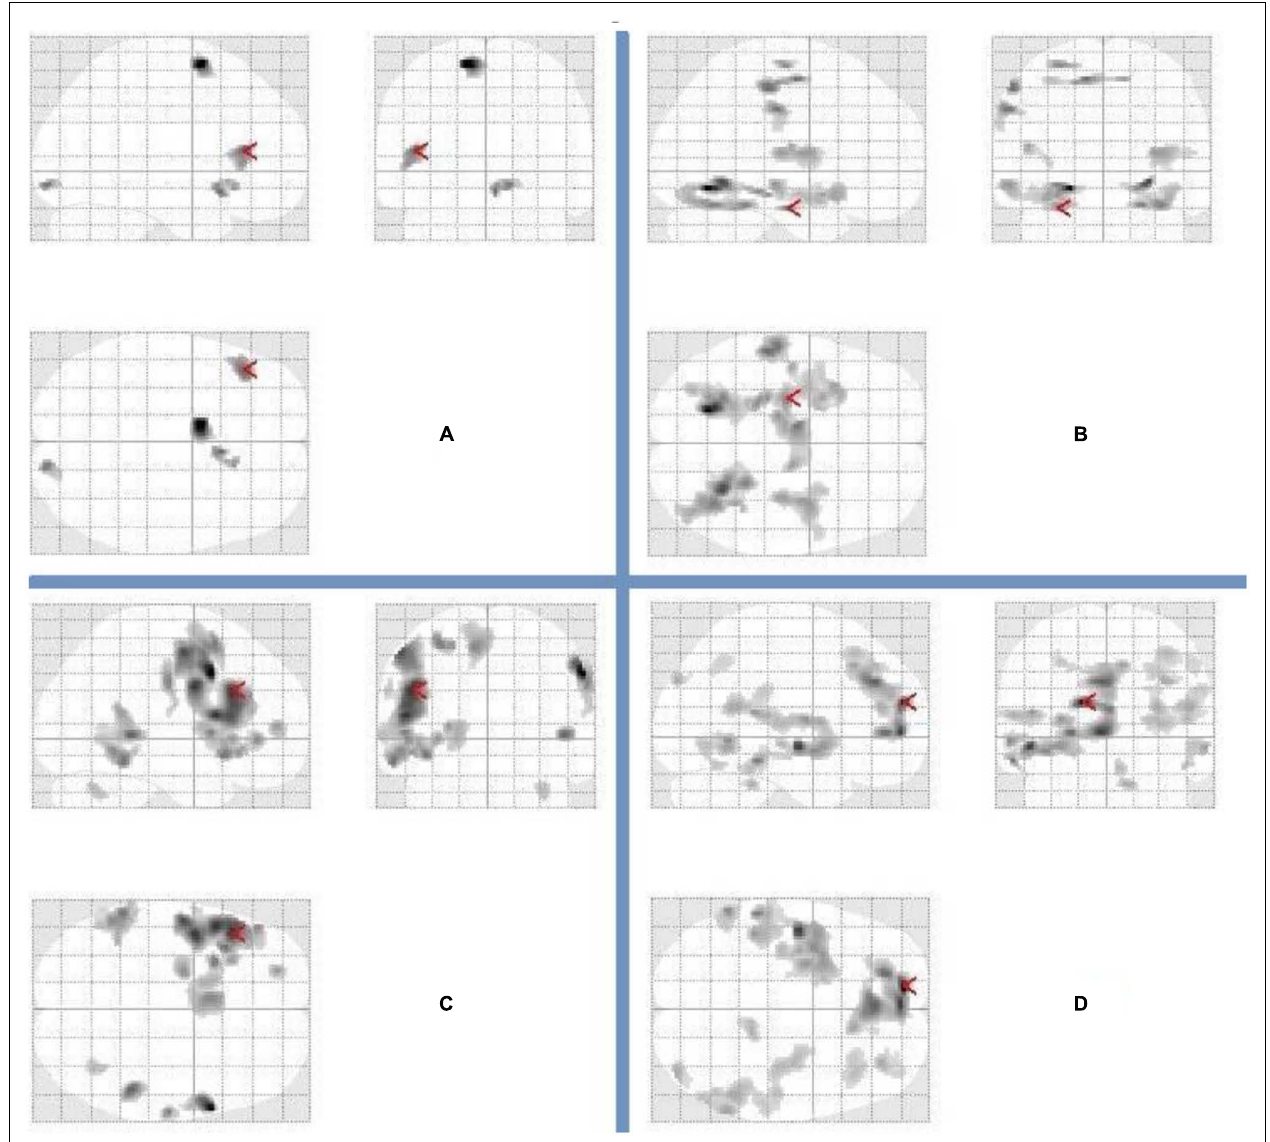
FIGURE 2 | Patterns of brain activation for divergent thinking (fluency) and recalling characteristics following a night of normal sleep and sleep deprivation. Glass brains representing activations in relation to (A) uses–rest following a night of normal sleep (arrow points to the left inferior frontal gyrus), (B) recalling characteristics–rest following a night of